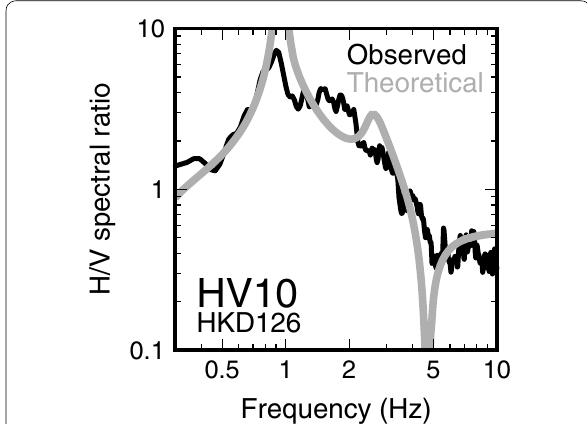
Fig. 11 Horizontal to vertical Fourier spectral ratios of the single station microtremor observations at the HV10 site, along with the theoretical ratio